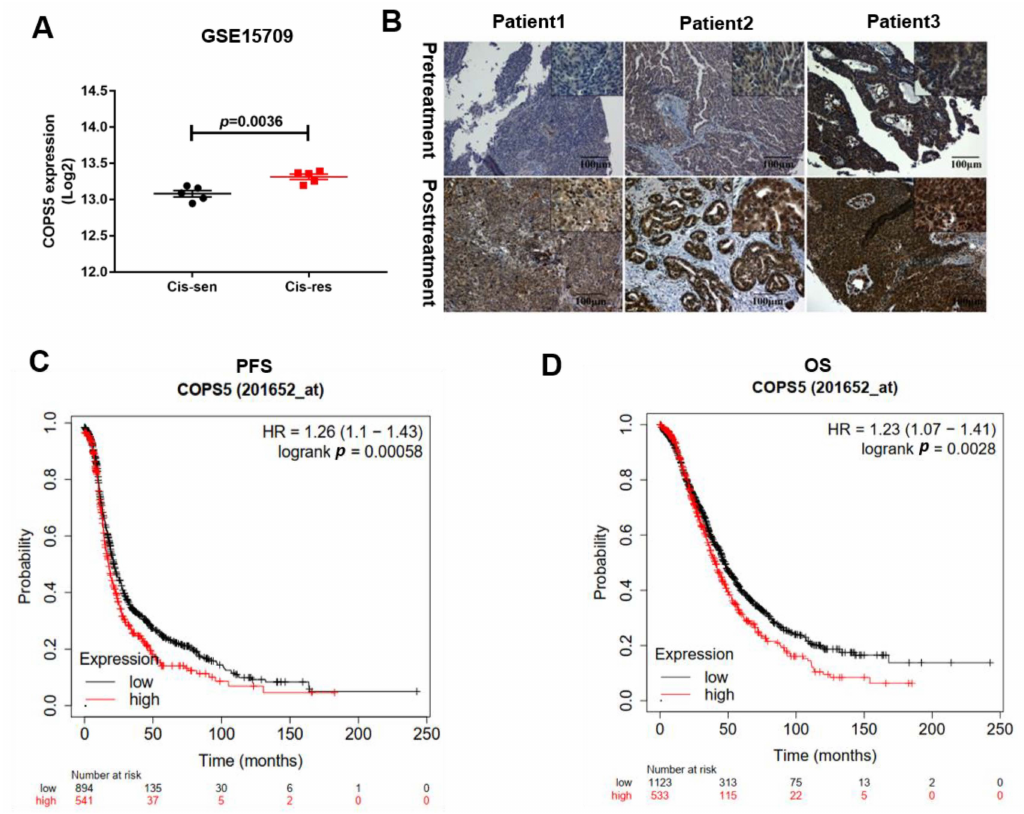
Figure 1. COPS5 is correlated with platinum resistance of EOC and involved in its prognosis. COPS5 was overexpressed in A2780 cisplatin-resistant A2780 cell lines (GSE15709) ( A ). IHC staining was robust in platinum-resistant EOC tissues ( B ). Patients with low levels of COPS5 had a prolonged PFS ( C ). Patients with low levels of COPS5 expression had a prolonged OS ( D